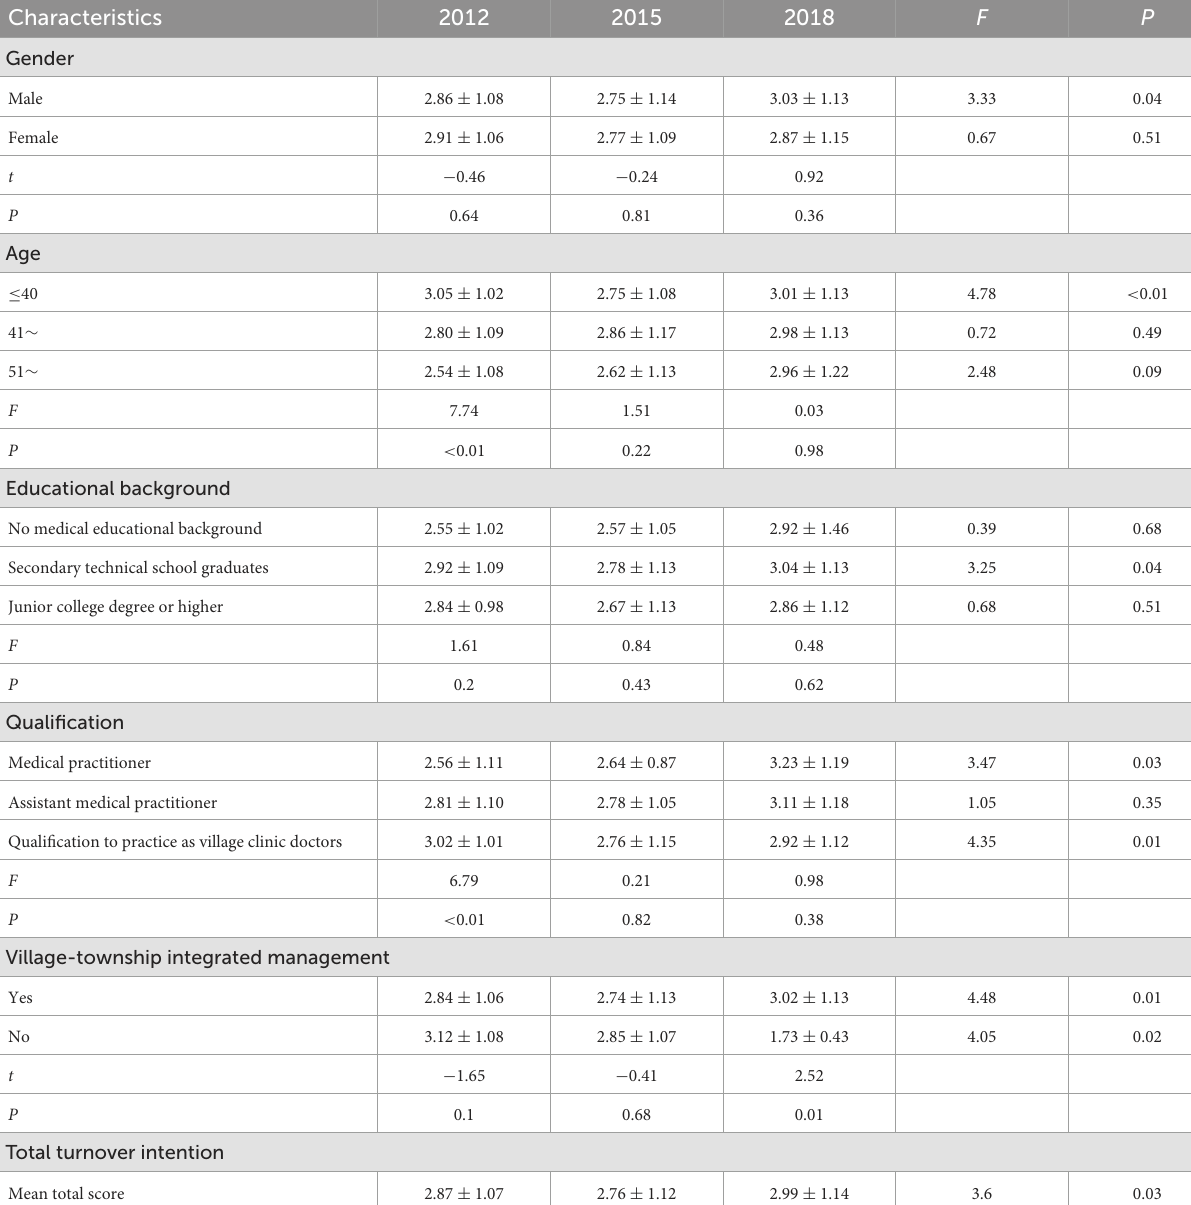
TABLE 2 Comparison of village clinic doctors’ turnover intention scores from three surveys.